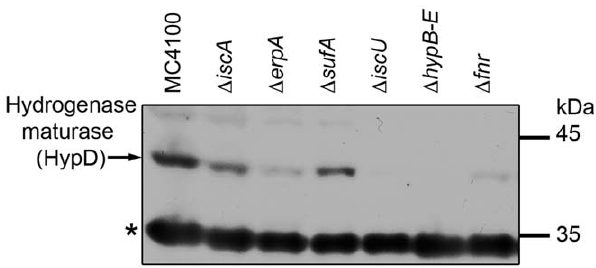
Figure 6. Identification of the HypD maturase in mutants defective in iron-sulphur cluster biogenesis. Aliquots (25 m g protein) derived from MC4100, CP477 ( D iscA ), LL402 ( D erpA ), CP1223 ( D sufA ), JW2513 ( D iscU ), BEF314 ( D hypB-E ) and PB1000 ( D fnr ) were separated by 10% (w/v polyacrylamide) SDS-PAGE and subjected to western blotting using anti-HypD antiserum. The asterisk indicates an unidentified cross-reacting polypeptide that served as an internal loading control. The migration positions of the molecular mass standards (in kDa) are indicated on the right of the